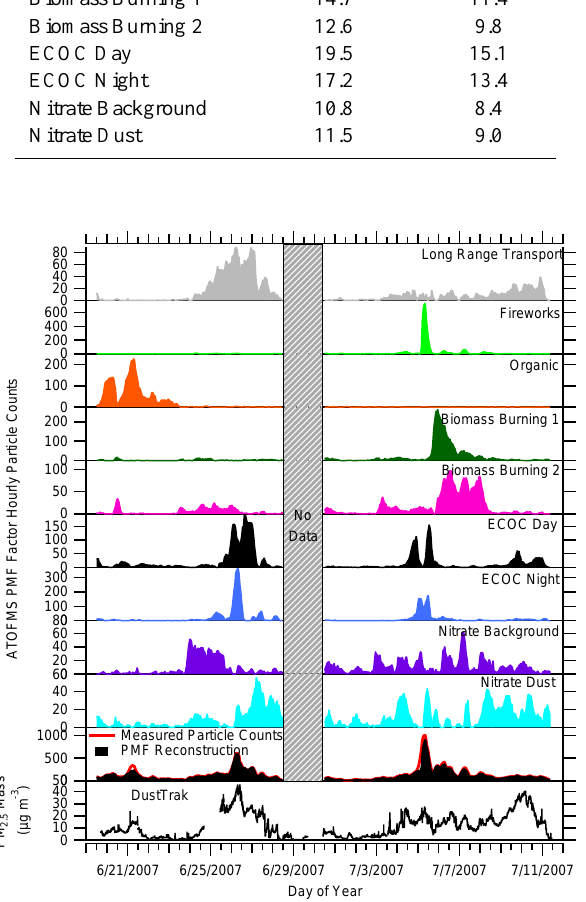
Fig. 2. Time series of the nine PMF factors’ hourly particle counts and the DustTrak PM 2 . 5 mass. No ATOFMS data was available for PMF analysis between approximately 12:00, 28 June and 12:00, 30 June as the ultrafine aerodynamic focusing lens (AFL030) was used at that time.